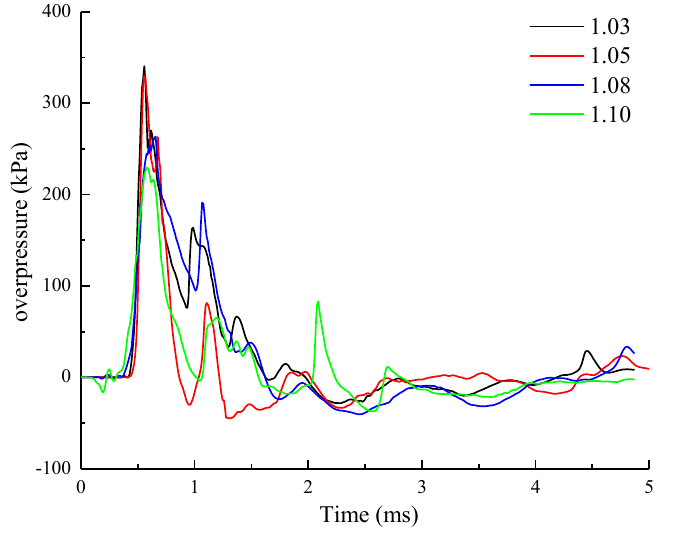
Figure 14. Earth-covered magazine model.